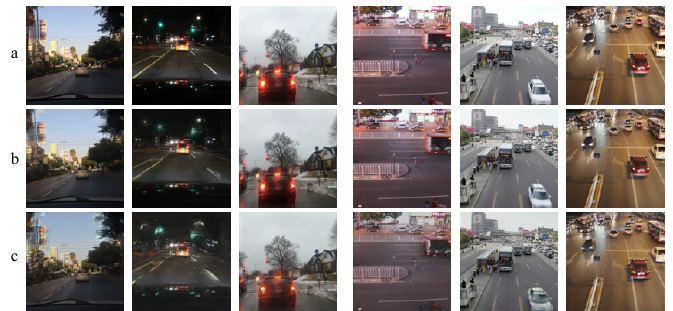
Figure 1. Exemplary results for the BDD100K [1] ( left ) and the UA-DETRAC [4] ( right ) datasets. ( a ) Last observed input frame, ( b ) and ( c ): Next frame predictions by the L1+Perceptual ( b ) and the generative adversarial network (GAN) loss model ( c ). The models were trained on Cityscapes using the different loss